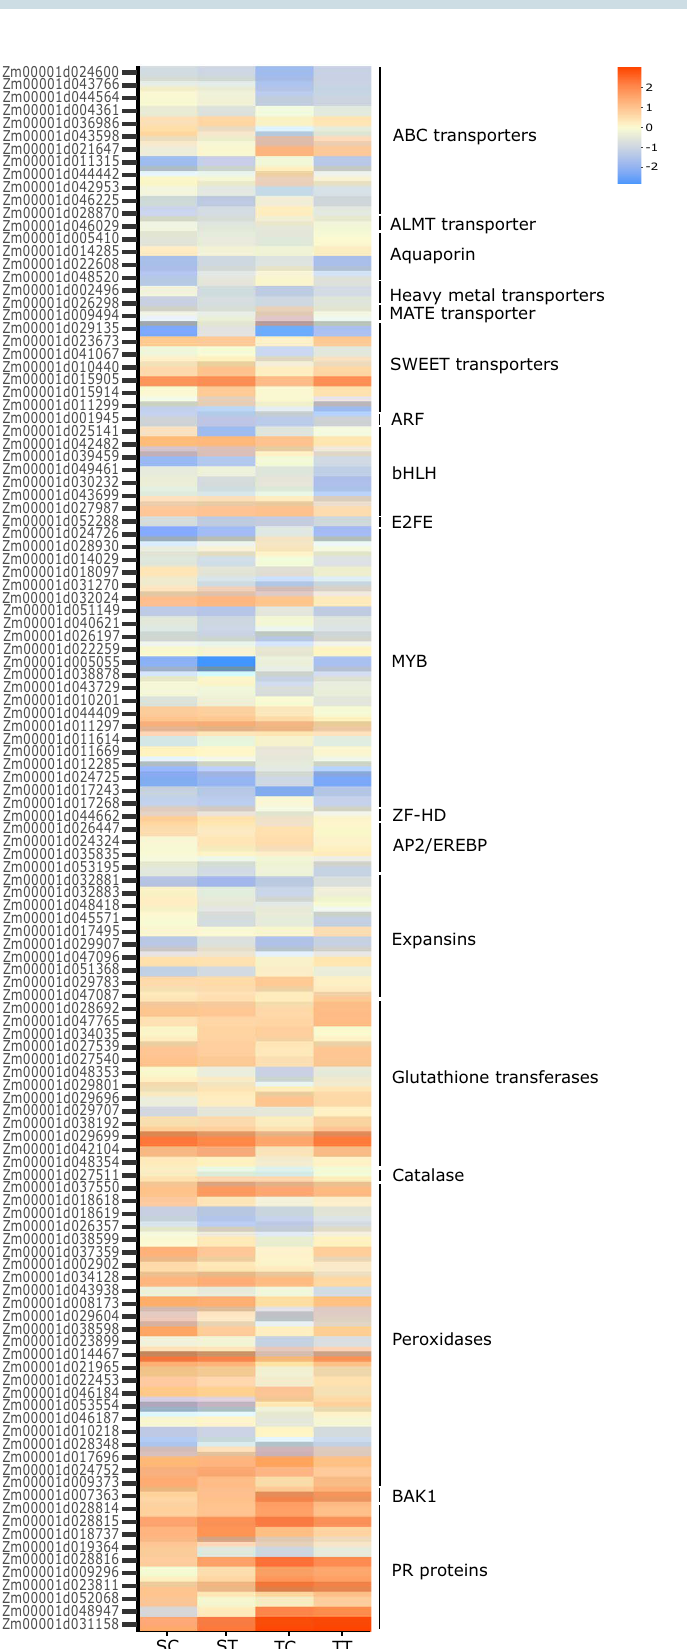
Figure 5. Heatmap of UPGMA clustering of selected candidate genes differentially expressed in Al-resistant inbred line. SC Al-sensitive control, ST Al-sensitive treatment, TC Al-resistant control, TT Al-resistant treatment. Heatmap was generated in R version 3.6.2 (https:// www.r- proje ct.